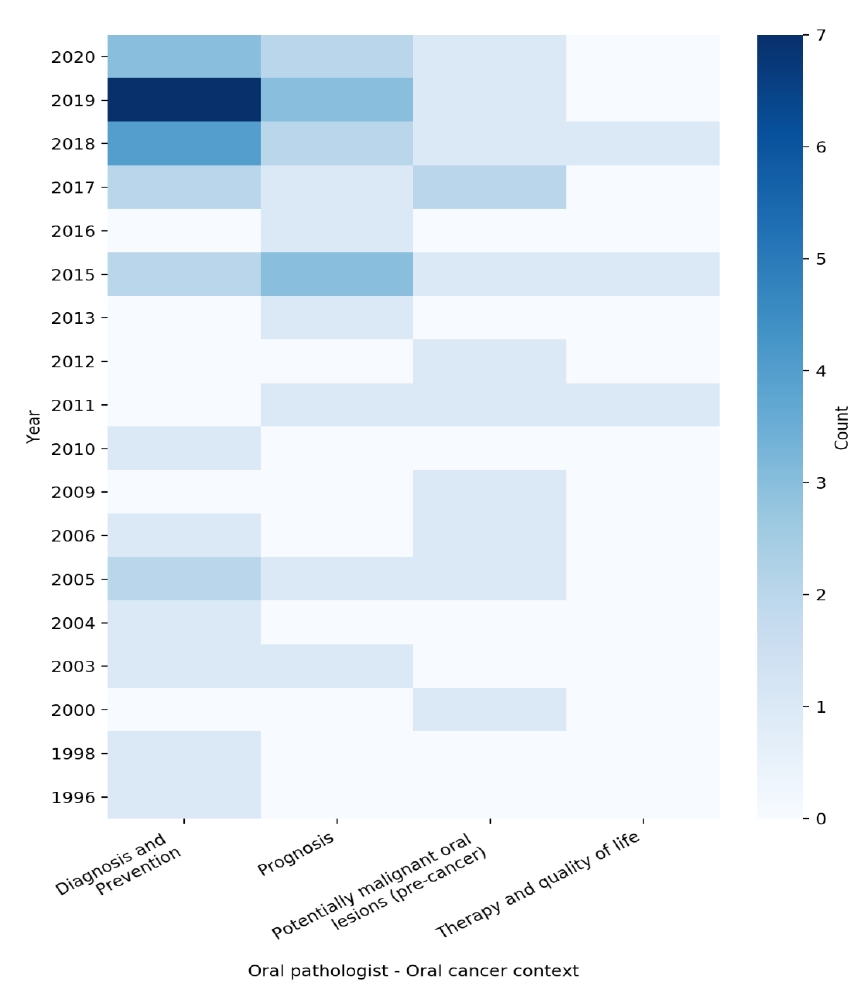
Figure 2 . Year-wise distribution of the number of publications on oral cancer